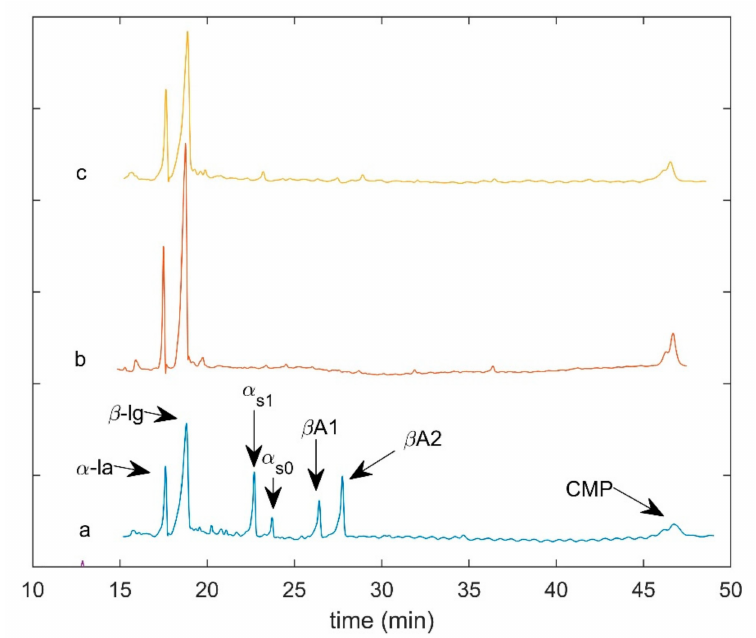
Figure 1. CE whey protein analysis: electropherograms of the first sampling point for each cheese type. ( a ) Grana type cheese; ( b ) Crescenza lab test; ( c ) Crescenza pilot scale. α -la ( α lactalbumin); β -lg ( β lactoglobulin); α